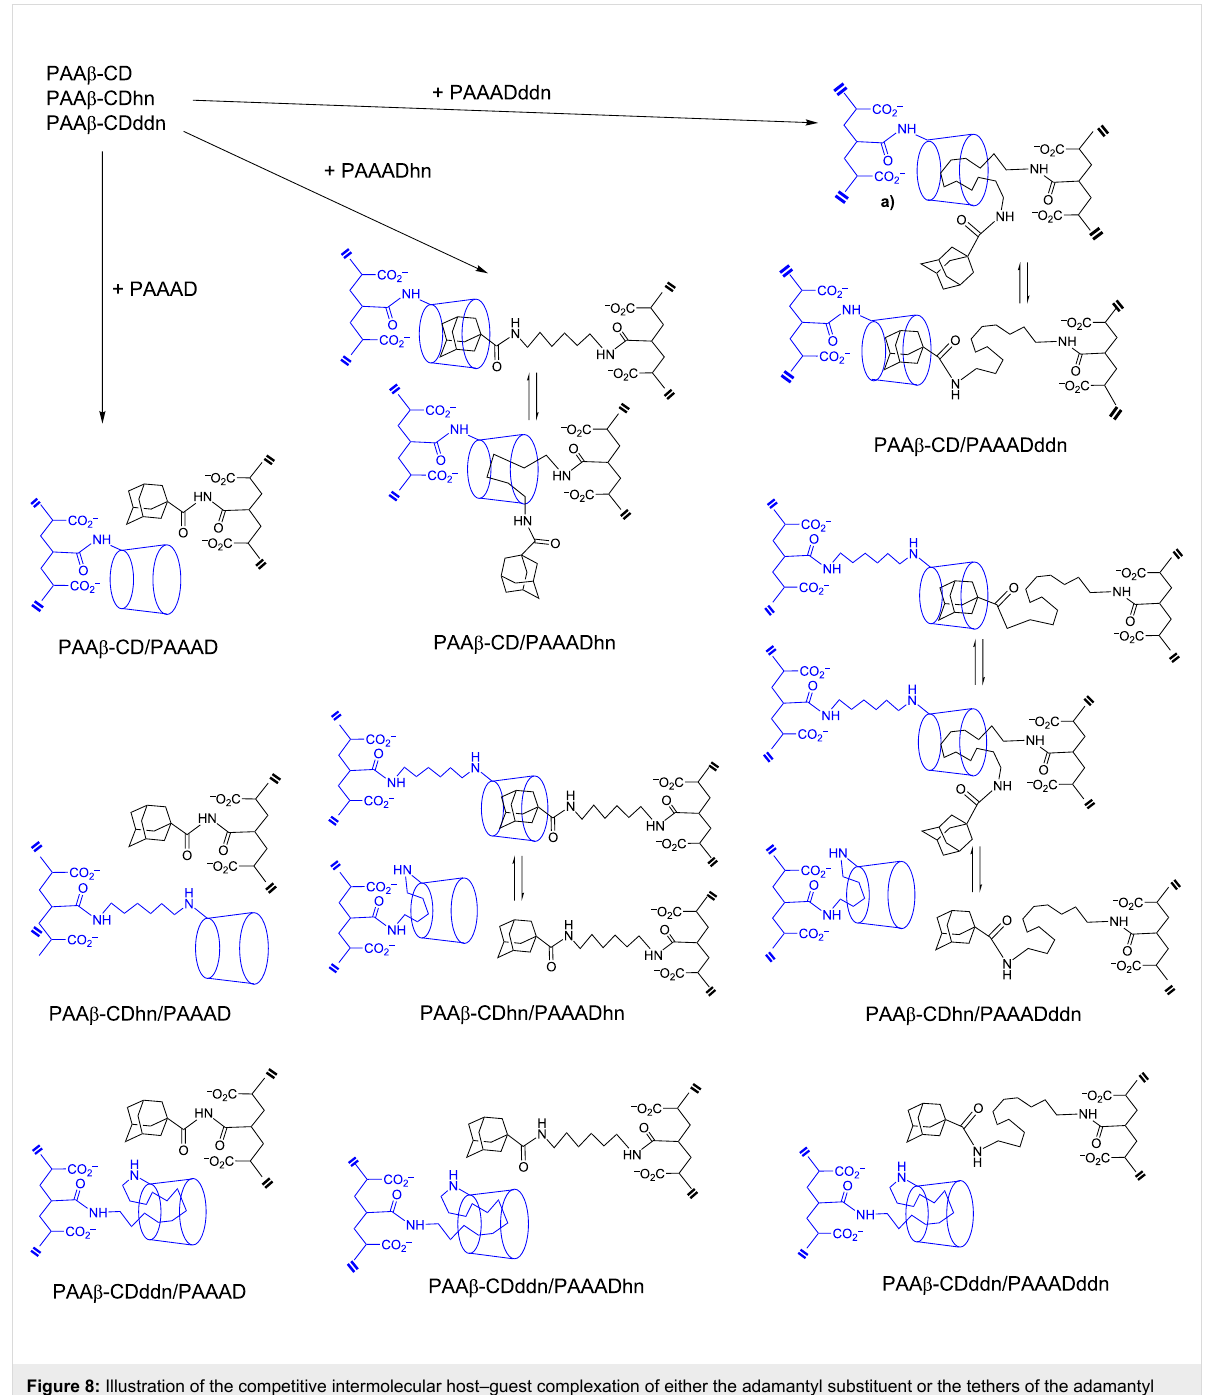
Figure 8: Illustration of the competitive intermolecular host–guest complexation of either the adamantyl substituent or the tethers of the adamantyl and β -CD substituents in a range of substituted poly(acrylate) systems. In each case β -CD is tethered to the PAA backbone through a C6 carbon in a D-glucopyranose subunit of each β -CD. Reproduced with permission from [72]. Copyright (2010) Wiley-VCH.